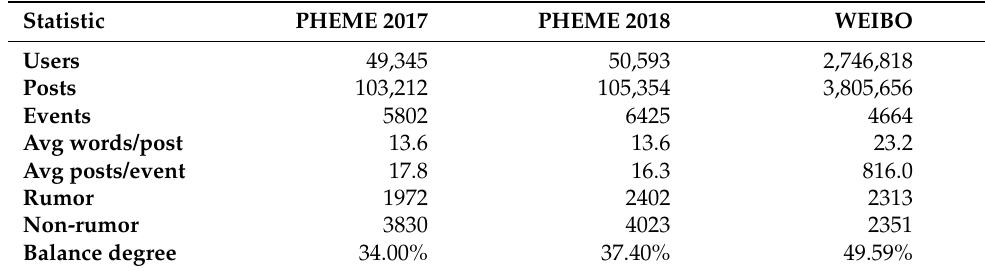
Table 1. The statistics of datasets used in this